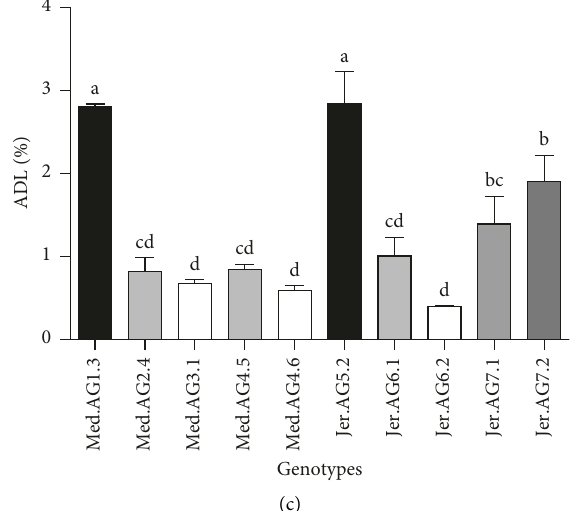
Figure 2: Fiber contents in the grains of the assessed millet genotypes; (a) neutral dietary fiber (NDF), (b) acid detergent fiber (ADF), and (c) acid detergent lignin (ADL). Values are averages ± SD (n � 3). Letters a–e denote statistical differences between assessed genotypes using Duncan’s multirange mean comparison test ( α � 0.05).